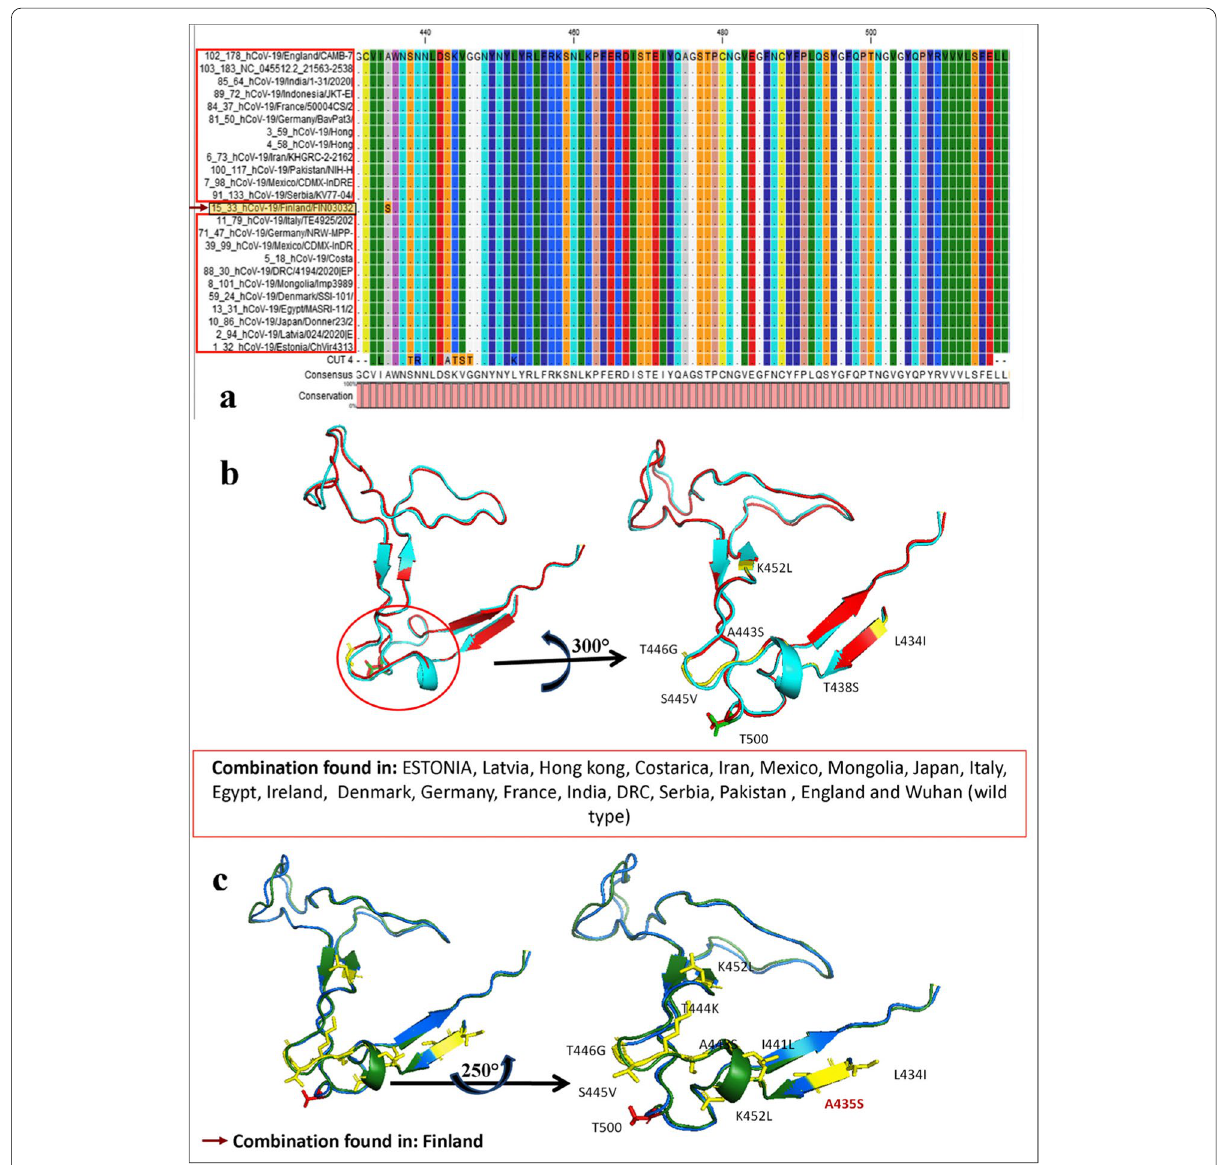
Fig. 4 CUT4 sequence alignment with 24 unique spike proteins from different countries. These 24 unique sequences were selected from 186 spike protein sequences representing 105 countries ( a ). Sequence diversity was observed in sequence FIN30302 where one Ser was observed at alignment position 435 and in CUT4 within alignment position 452. Whereas, all other sequences showed identical sequences over the CUT regions. The sequence diversity with CUT4 did not reflected at the T500 position for both b and c . Which indicated that mutated CUT4 can able to compete with all type of COVID -19 spike glycol proteins throughout 105 countries in the